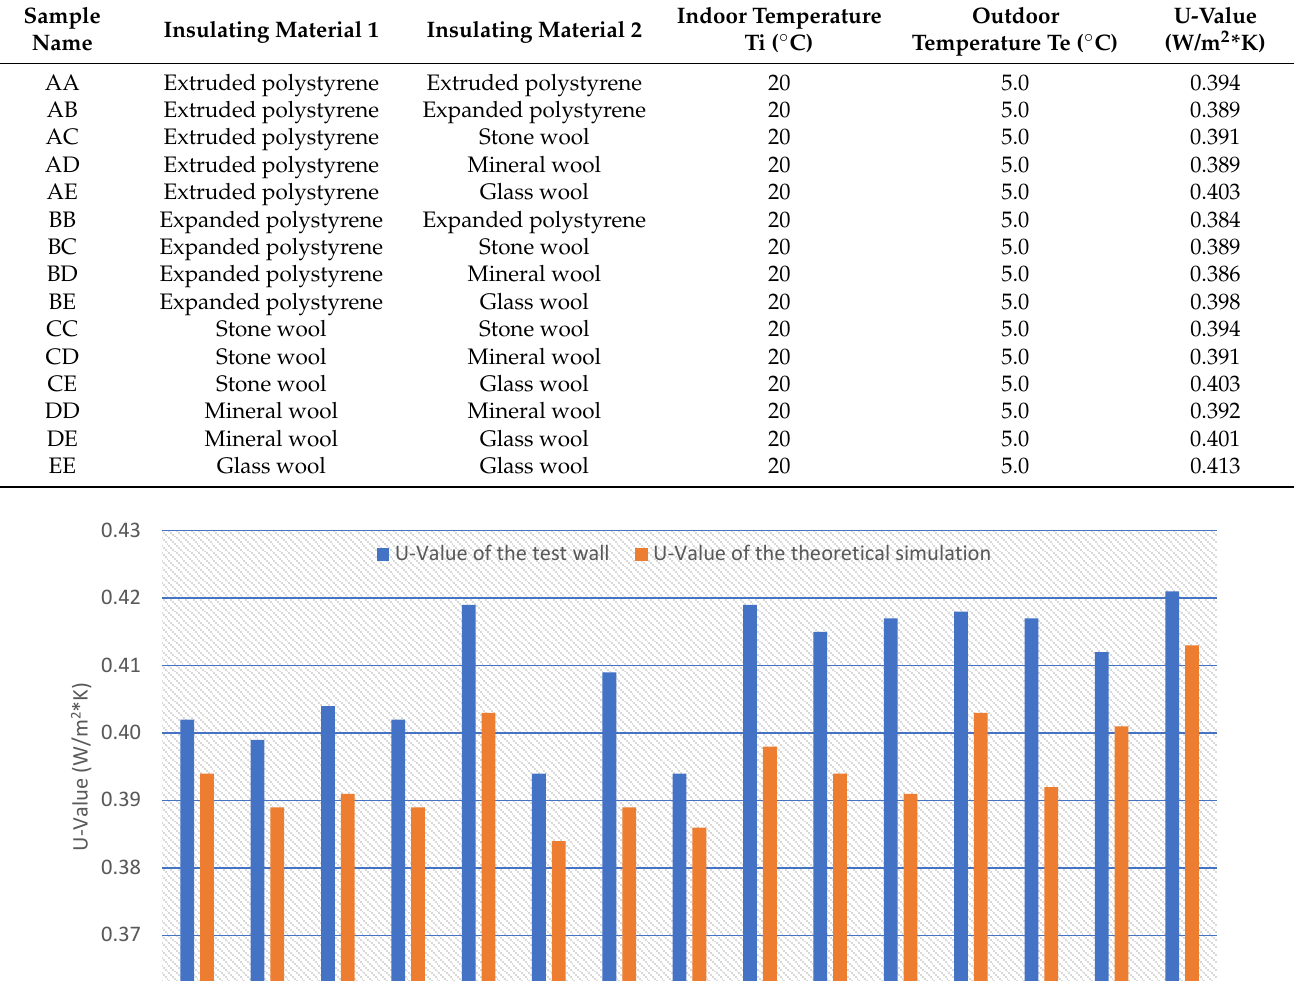
Table 5. The readings of the thermal transmittance, the indoor and outdoor temperatures through a theoretical analysis with the combinations of the insulating materials.